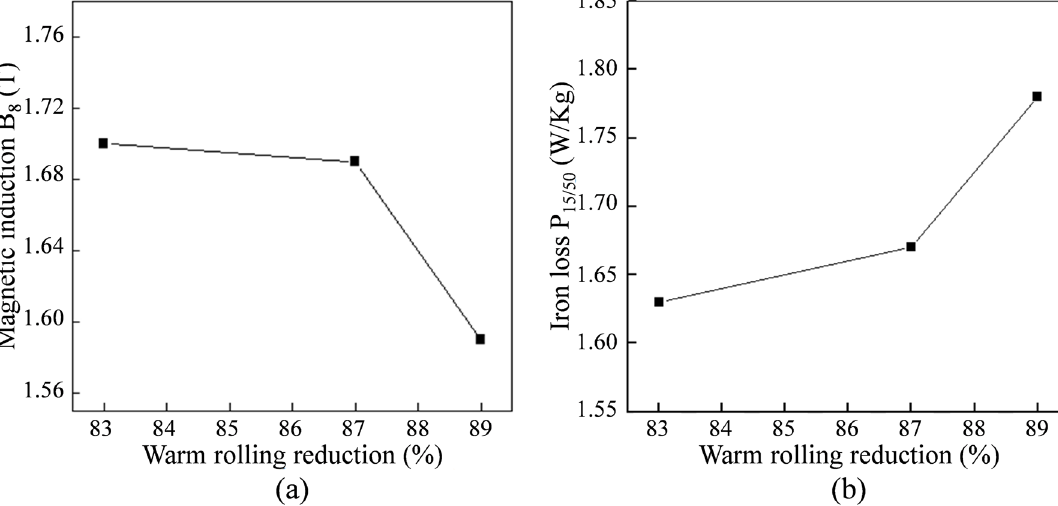
Figure 10. (a) Magnetic induction and (b) iron loss in Fe-4.5 wt.% Si sheets after purification annealing at 1200